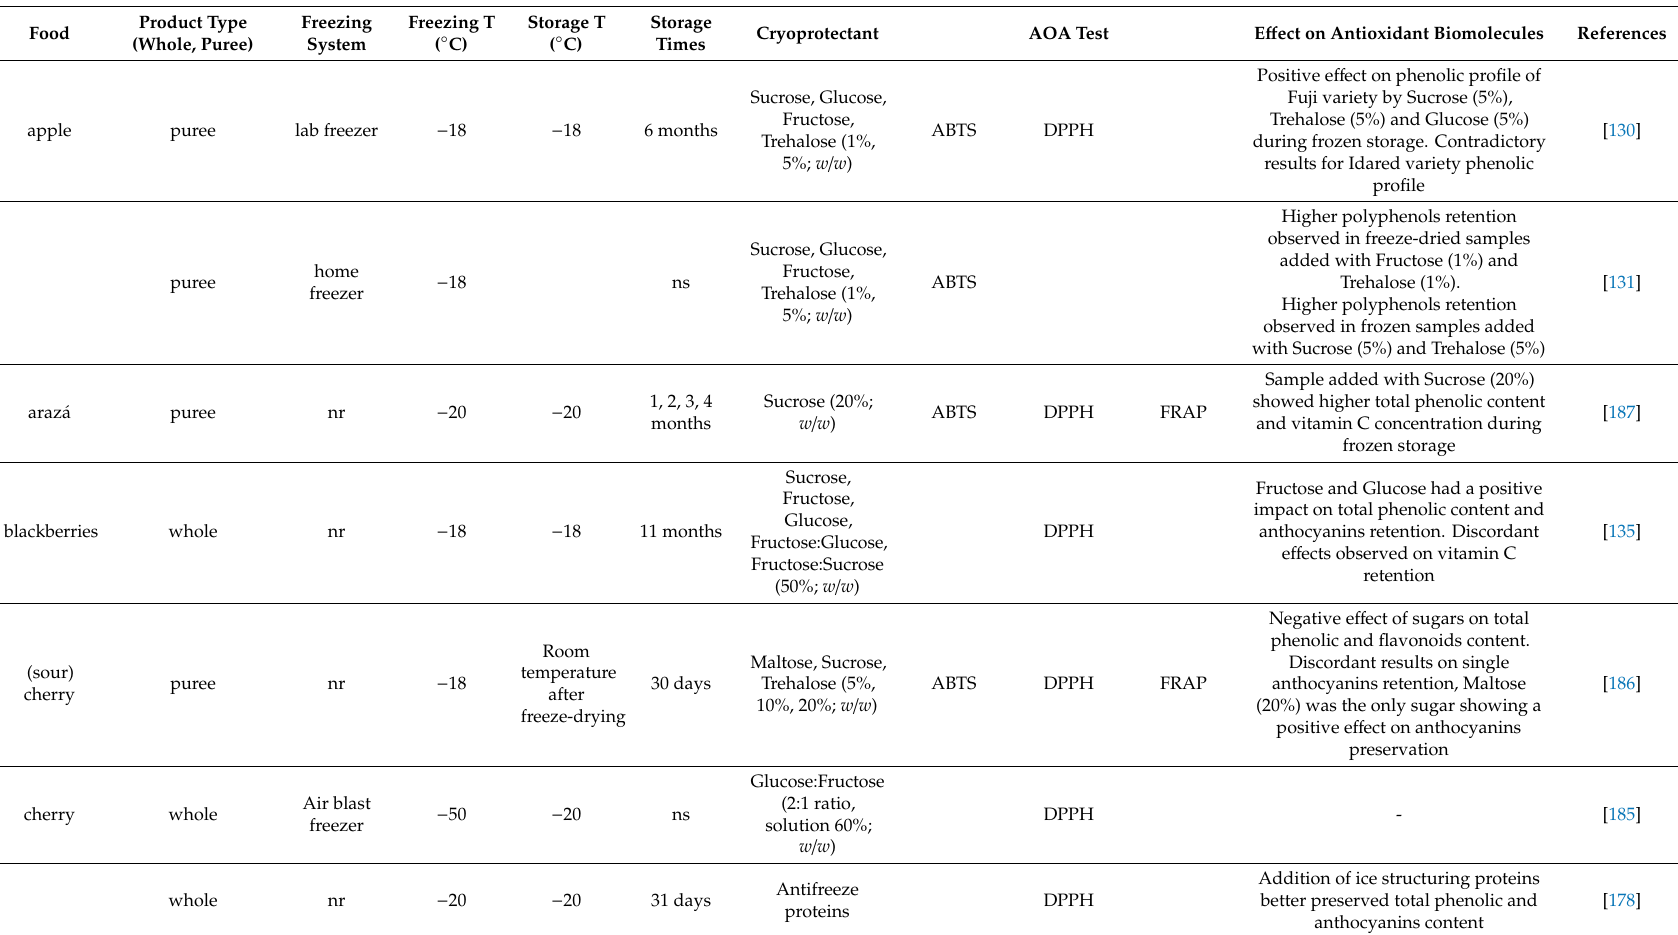
Table 3. Evaluation of antioxidant activity (AOA) of fruits and vegetables subject to freezing pre-treated with